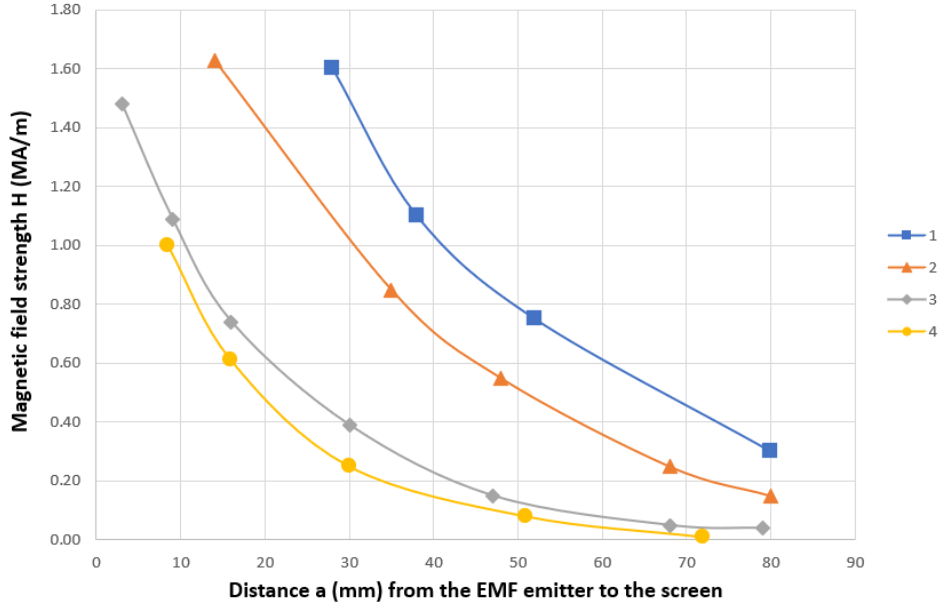
Figure 19. Damping of pulsed EMF in the axial and transversal position of the screen shielding: 1 – axially to magnetic flux without shielding screen; 2—axially to magnetic flux shielding screen; 3—transversally to magnetic flux without shielding screen, 4—transversally to magnetic flux shielding screen.